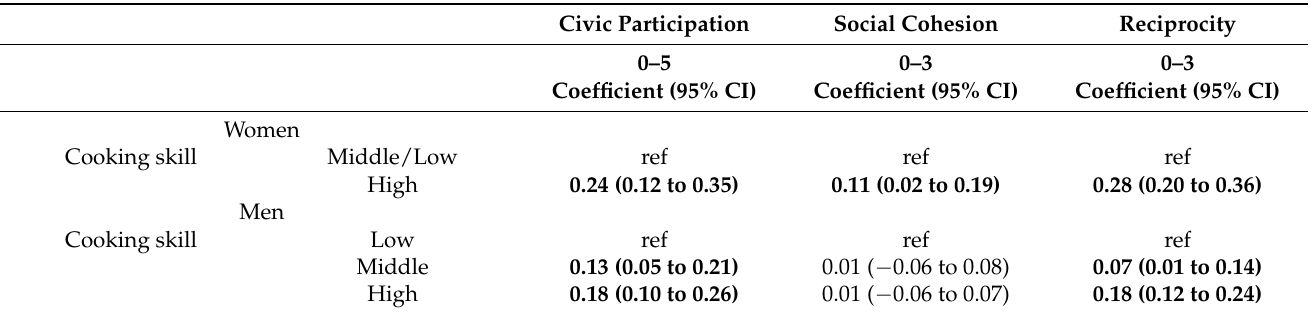
Table 2. Results of regression analyses of social capital according to the level of cooking skill among older adults in Japan.